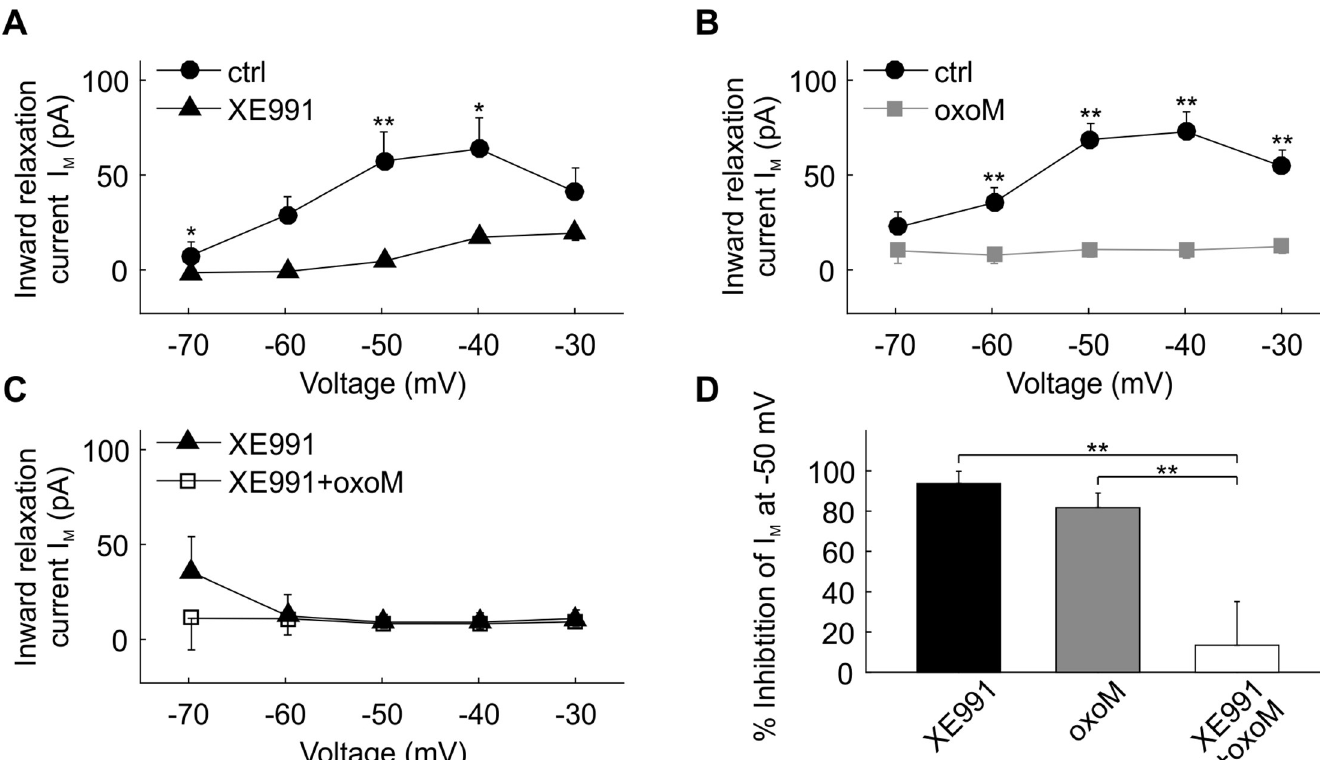
Fig 3. Quantification of I M suppression by oxoM in SBCs. (A) Voltage-current relationship of the mean of the inward relaxation current I M (n = 5) in control and after application of XE991. (B) Voltage-current relationship of the mean of the inward relaxation current I M (n = 8) in control and after application of oxoM. (C) Voltage-current relationship of the mean of the inward relaxation current I M (n = 5) in presence of XE991 and after application of oxoM. (D) Percentage of I M at -50 mV inhibited by the application of XE991 (black), oxoM (grey) and oxoM in presence of XE991 (white). Application of XE991 or oxoM alone strongly reduced the inward relaxation current I M at -50 mV. Application of oxoM only inhibited a small amount of the residual I M when the cell was pre-treated with XE991. � p < 0.05; �� p <